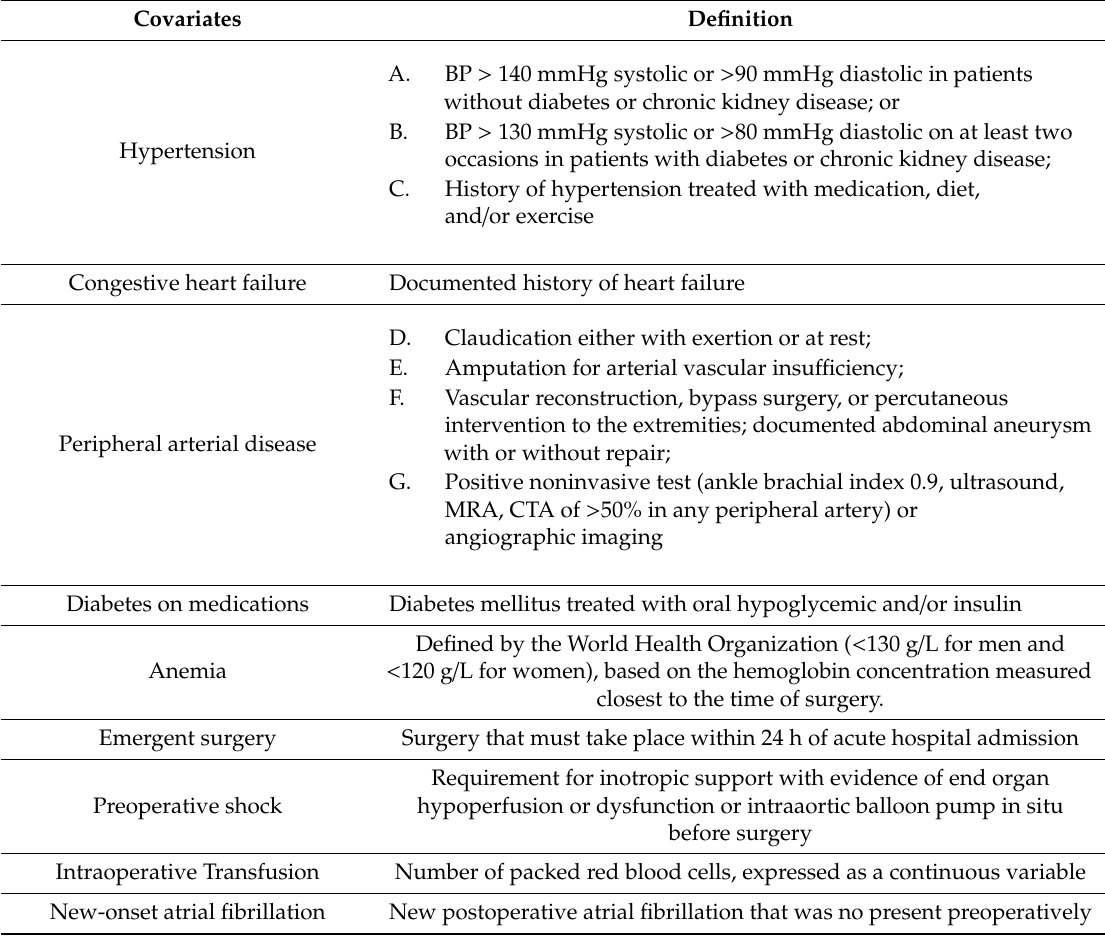
Table A1. Covariates and their